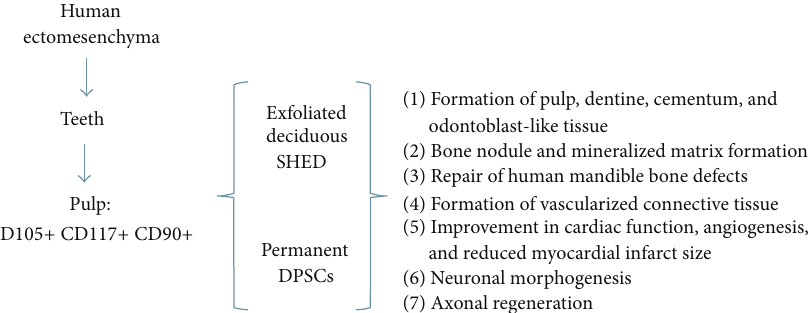
Figure 1: Human DPSC results achieved up to now. DPSCs: stem cell derived from permanent teeth; SHED: stem cell derived from human exfoliated deciduous